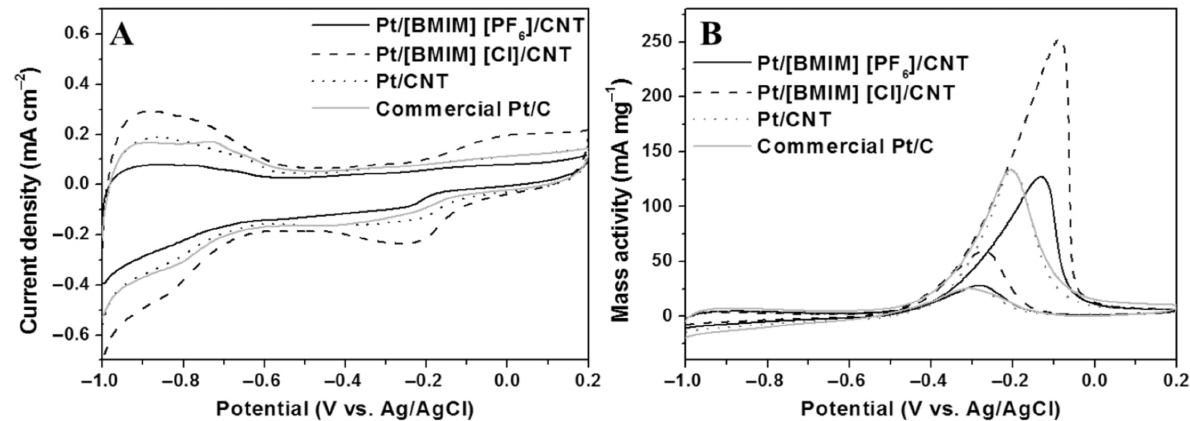
Figure 3. (A) EASA and (B) CV curves of Pt/[BMIM][PF 6 ]/CNT, Pt/[BMIM][Cl]/CNT, Pt/CNT nanohybrids, and commercial Pt/C NPs elec- trodes. (A) EASA was estimated by integrating the charges associated with hydrogen desorption in 0.5 M KOH. (B) CV was conducted in 0.5 M KOH containing 0.5 M methanol. Scan rate: 100 mV s (cid:1) 1